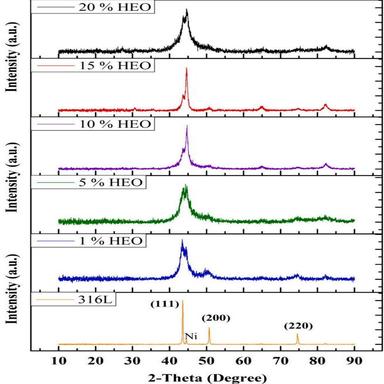
XRD spectra of the composite samples containing 1 % HEO, 5 % HEO, 10 % HEO, 15 % HEO and 20 % HEO.